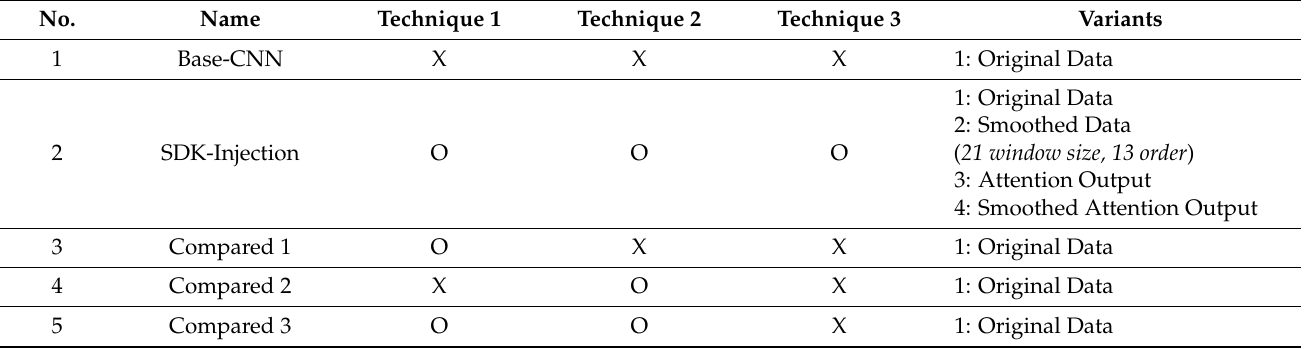
Table 5. Description of SDK-Injection and other comparison methods derived from the combination of three